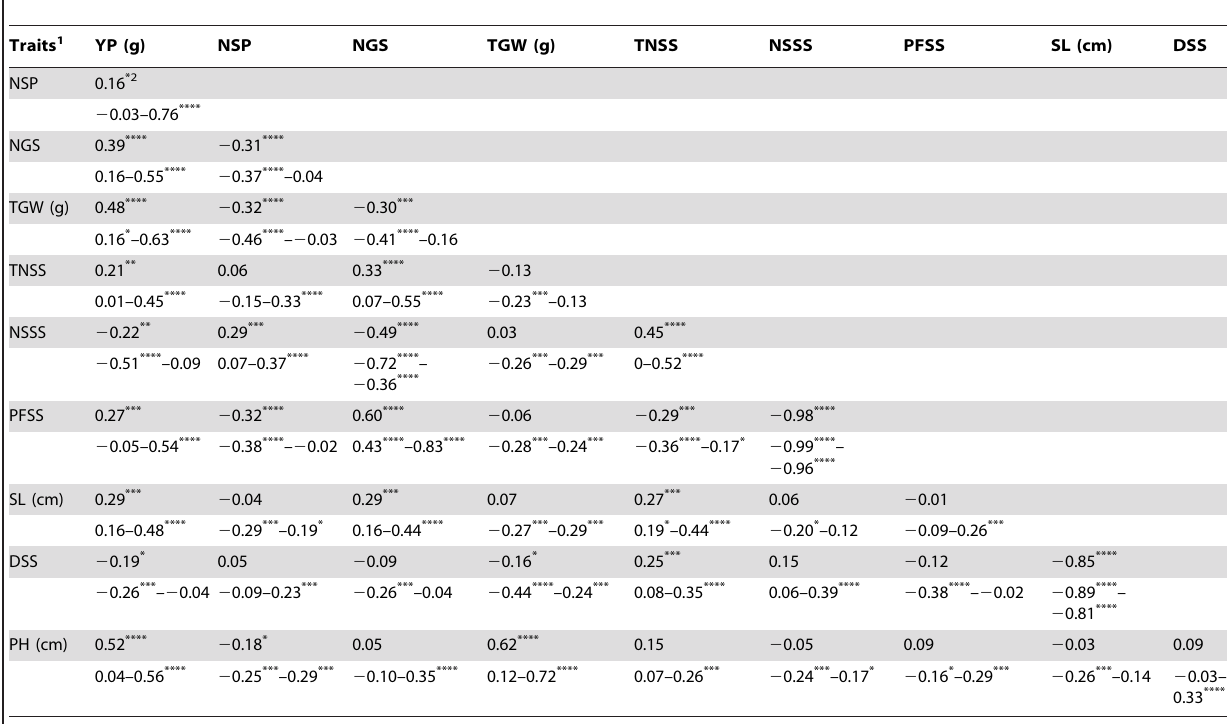
Table 2. Pearson’s correlation coefficients between yield-associated traits in wheat DH lines grown in the different environments.